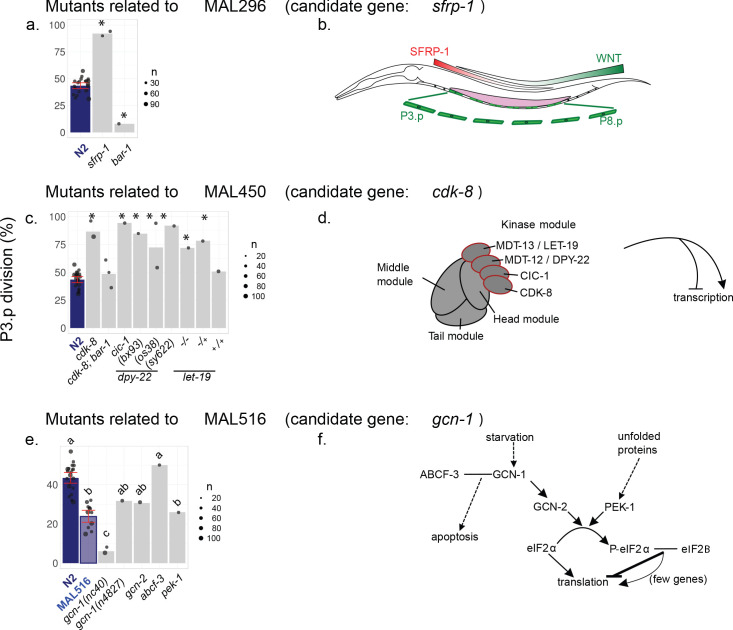
P3.p cell fate in different mutants related to the candidate mutation found in MA lines 296 (a), 450 (c) and 516 (e).All mutants are derived from the N2 laboratory reference strain. Bar charts represent the mean frequency of P3.p division. Each dot is an independent experiment, whose size scales to the number of animals scored (n). Data for N2 (from Figures 2–4) are repeated on each panel as a reference. Error bars indicate 95% confidence intervals. Stars indicate significant differences with N2 in P3.p division frequency over all experiments and in (e), different letters indicate a significant difference (Fisher's exact test, fdr 0.05). Panels b,d,f provide information about the genes studied in each panel. (b) SFRP-1 expression generates a head-to-tail gradient counter-acting the tail-to-head Wnt gradient. Wnt signaling is known to promote VPC competence and lack of fusion in the L2 stage. (d) Schematic structure of the Mediator complex in C. elegans, made of four multiprotein complexes (head, middle, tail and kinase modules). The Mediator regulates transcription both positively and negatively. Mutants for the four proteins of the kinase module were assayed in (c). (f) Functional pathways related to the GCN-1 kinase in C. elegans. GCN-1 directly activates GCN-2 under starvation condition, which in turns phosphorylates eiF2α leading to a global repression of translation. PEK-1 kinase acts like GCN-2 under unfolded-protein stress. Physical interaction of GCN-1 with ABCF-3 has been shown to promote apoptosis in specific cells, although the involvement of translational regulation is unclear (plain arrows = direct activation, plain T-bar = direct inhibition, dotted arrow = indirect activation, plain line = physical interaction).